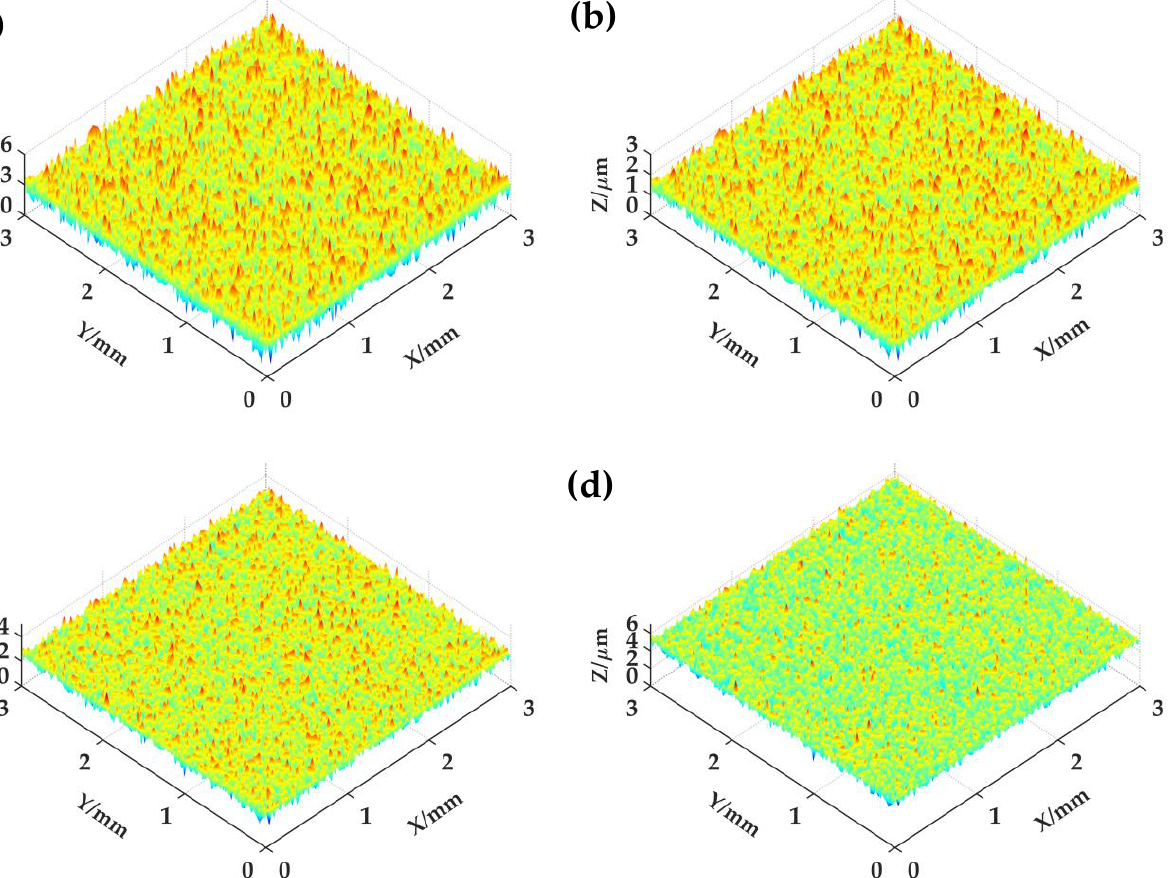
Figure 5. Fractal surfaces: ( a ) Surface 1; ( b ) Surface 2; ( c ) Surface 3; ( d ) Surface 4.